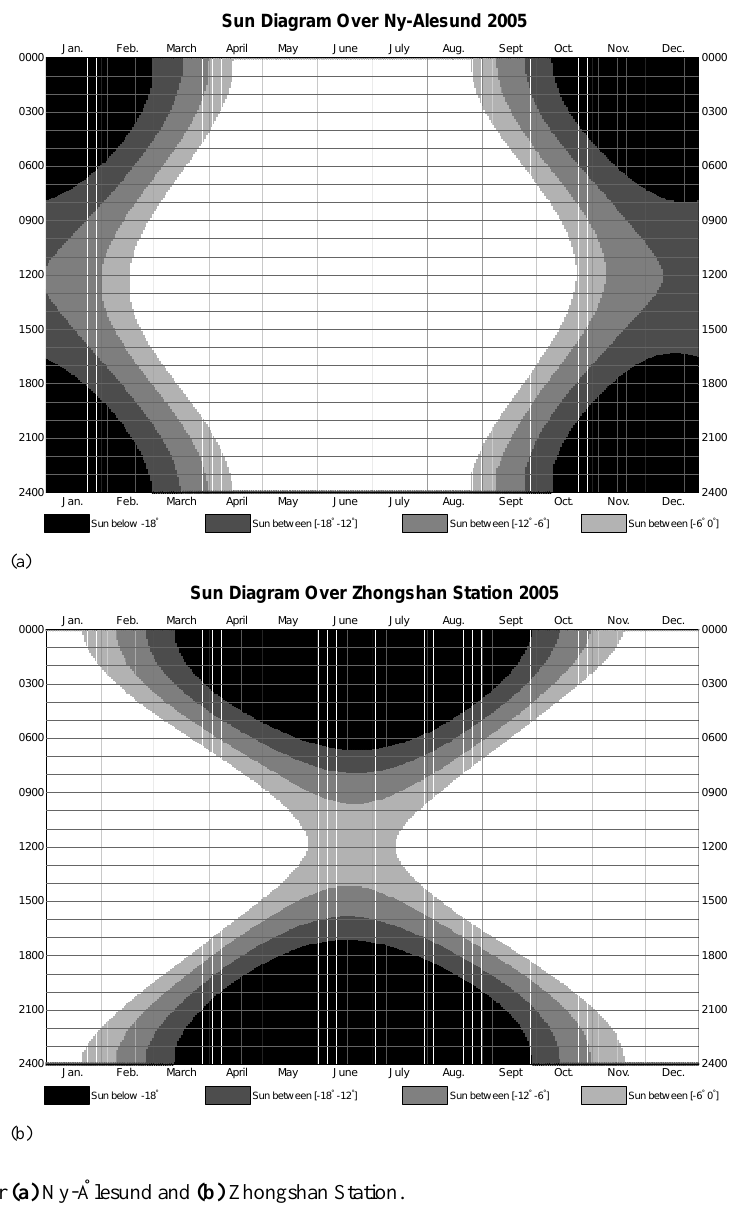
Fig. 5. The Sun diagram over (a) Ny- ˚Alesund and (b) Zhongshan Station.